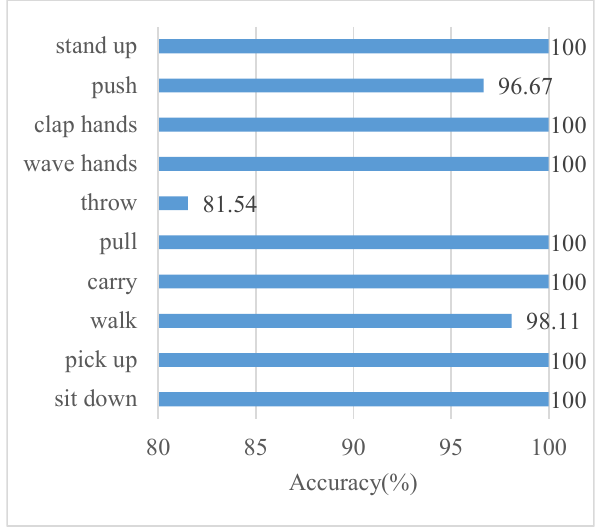
Figure 7. The recognition accuracy of each action on UTkinect-3D dataset using our method.